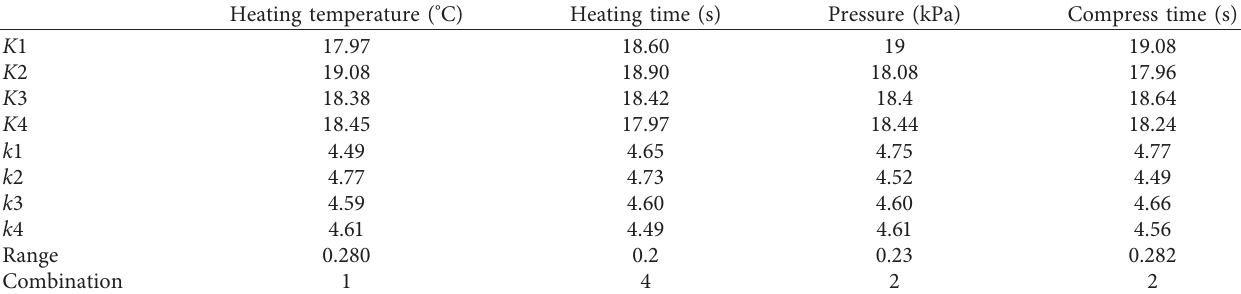
Table 4: Influence of various factors on the maximum thickening